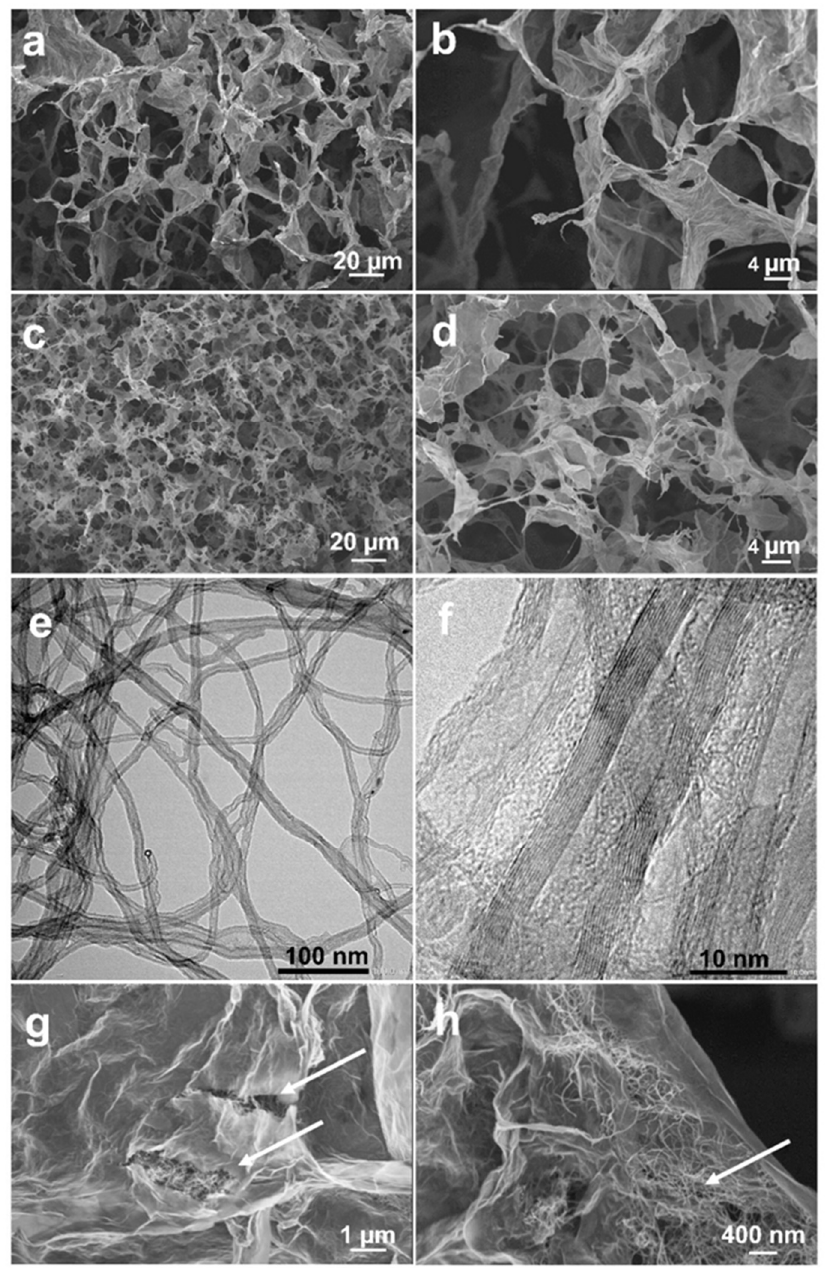
Figure 2. SEM images of increasing magnification (from left to right) of: pure GO aerogel ( a , b ), PA- MAM (0.2 mg mL − 1 ) modified GO aerogel ( c , d ), CNTs ( e , f ), and PAMAM/CNT (0.2/0.06 mg mL − 1 ) modified GO aerogel ( g , h